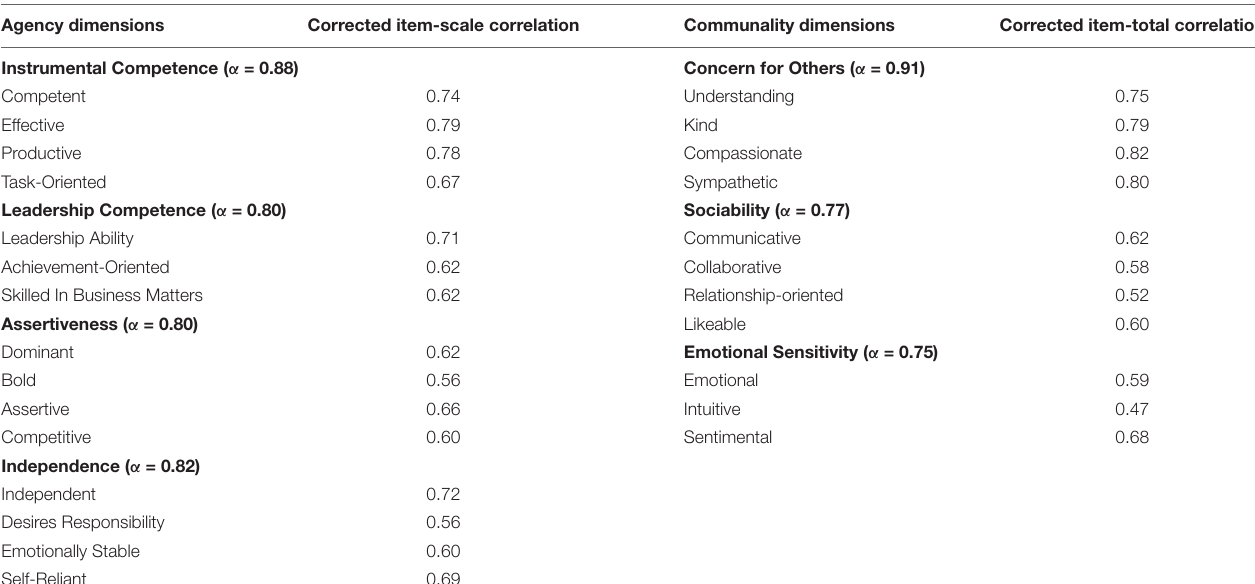
TABLE 1 | Dimension scales, scale items, and reliability information. Agency